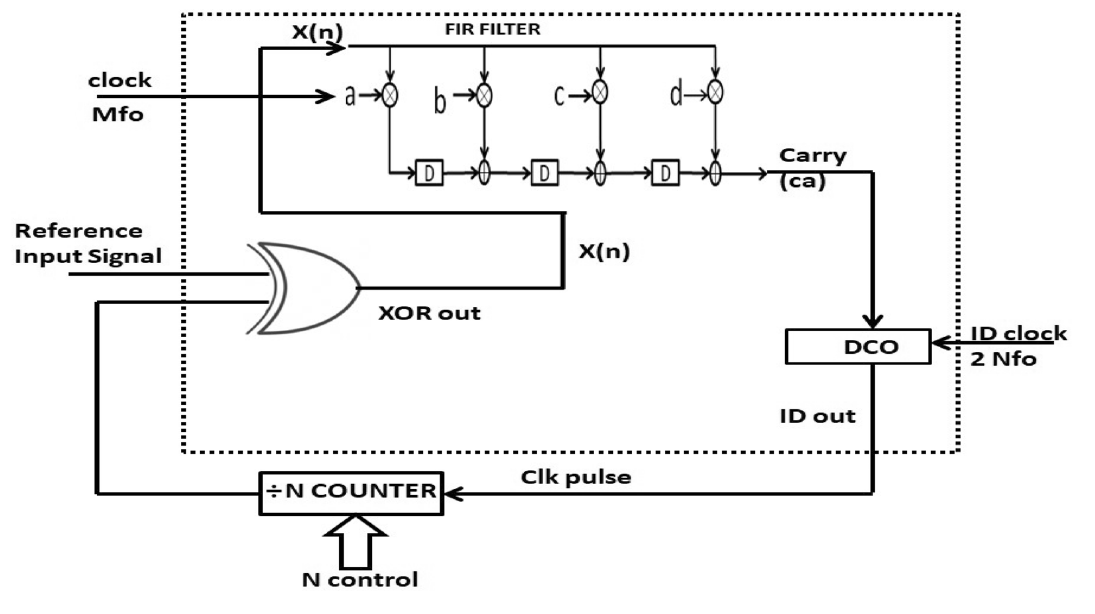
Fig. 3 First-order ADPLL circuit diagram